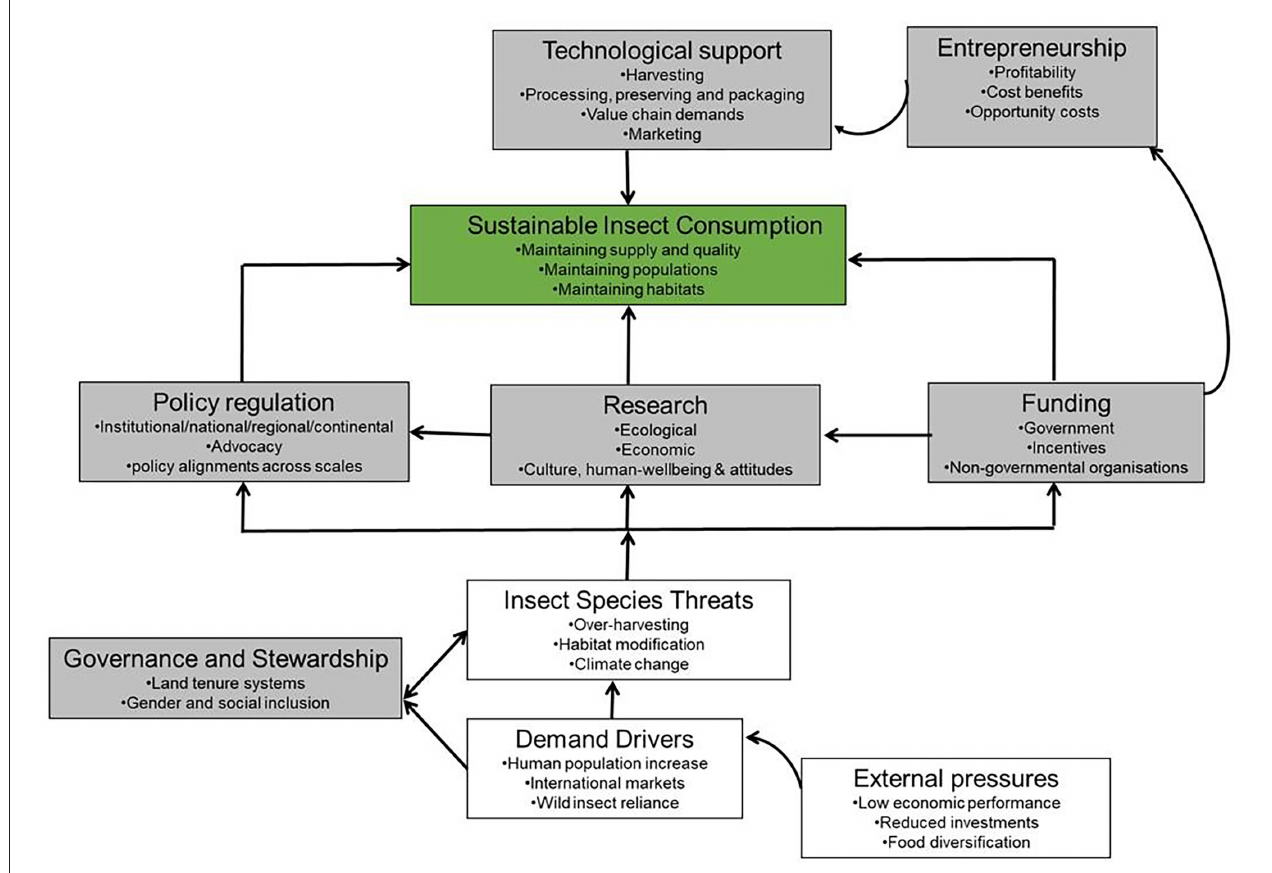
FIGURE 4 | A schematic presentation of the conceptual framework of issues around promoting policy integration for sustainable edible insect consumption. The gray boxes represent sections where human interventions can be applied and the green box is the desired outcome of the process in a SSA